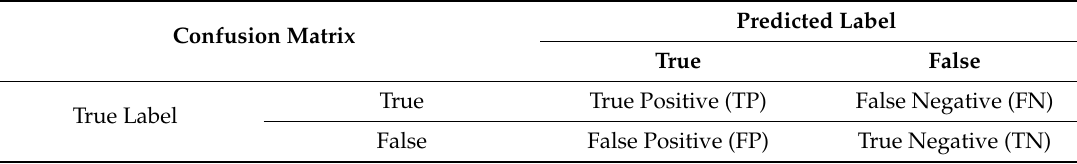
Table 2. The confusion